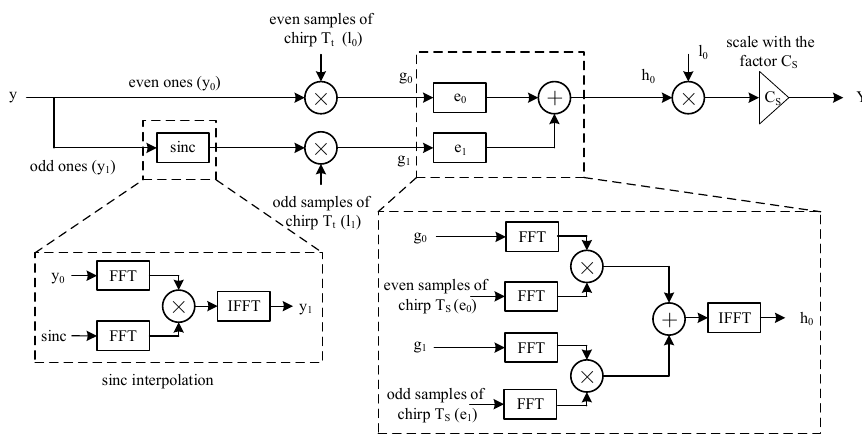
Figure 1. Multi-path parallel fast algorithm of fractional Fourier transform